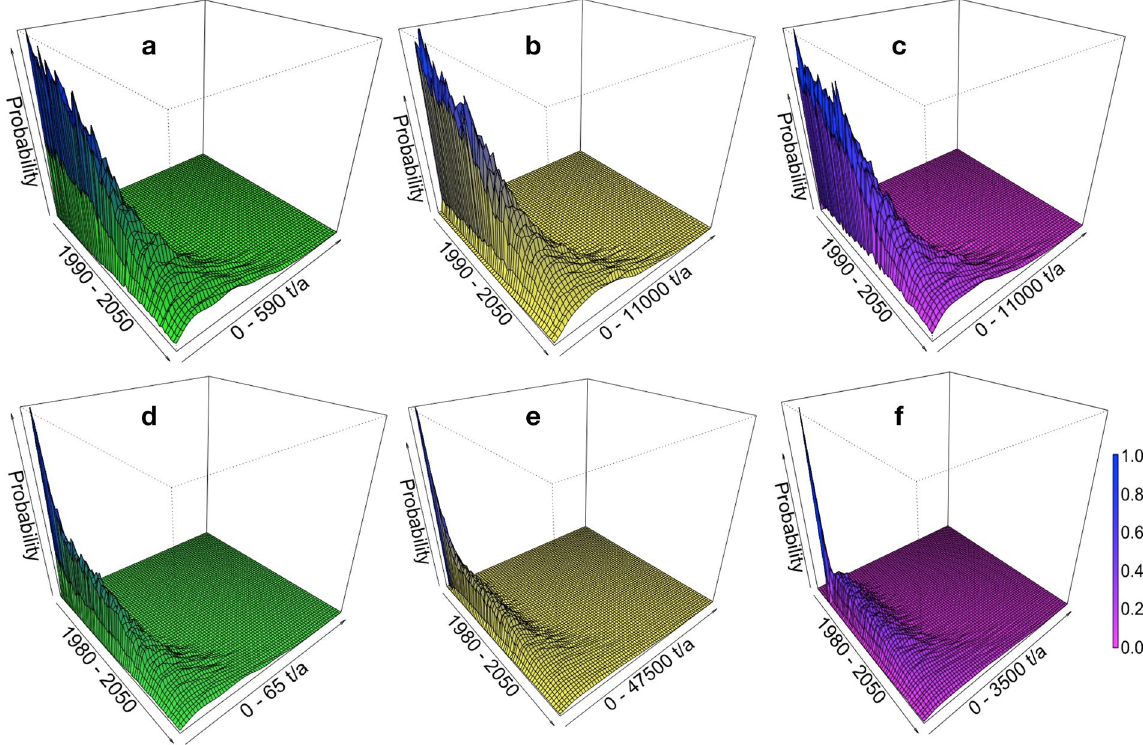
Figure 4. Predicted ENM mass (most probable range) between 1990 and 2050 (1980 and 2050) from two exemplary and relevant CeO 2 -ENM applications. From left: ENM release mass to nature ( a and d ), ENM mass ( b and e ) in circulation (release delay during product use), and ENM mass ( c and f ) deposited or eliminated in technical treatment (landfilling, recycling, waste incineration, and sewage treatment). Above ( a – c ), chemical- mechanical polishing (CMP) application; below ( d – f ), use for ACCs (automotive catalytic